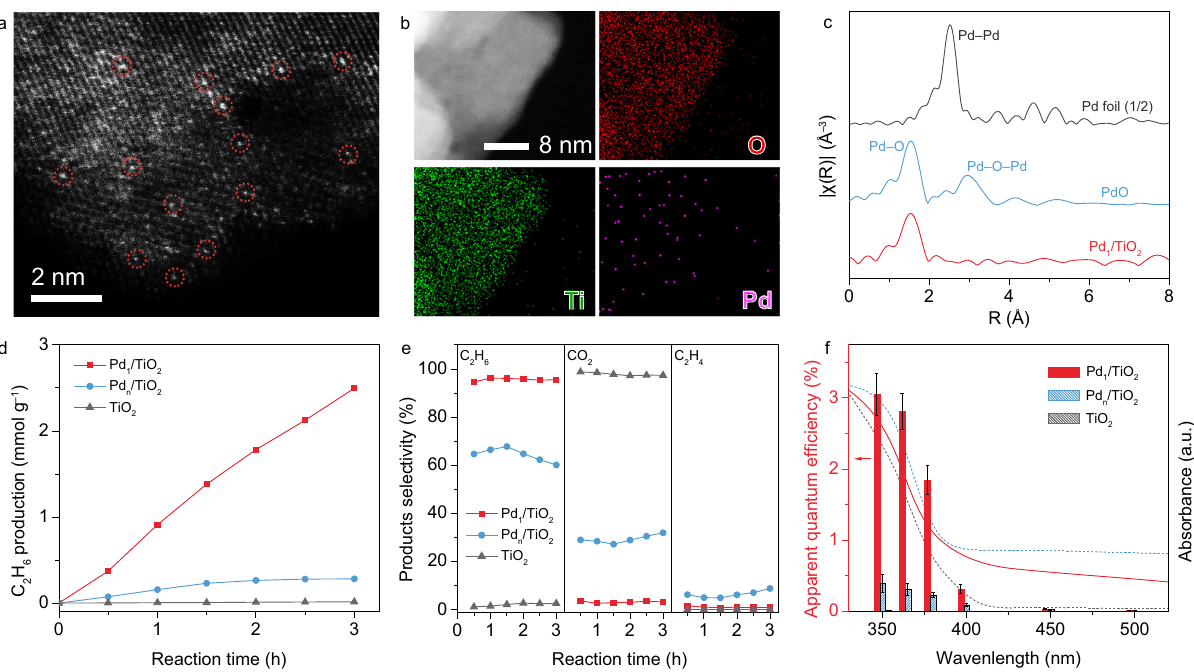
Fig. 2 Structural characterization and photocatalytic NOCM performance of Pd 1 /TiO 2 catalyst. a – c STEM image ( a ), elemental mappings ( b ) and Pd K-edge EXAFS spectra in R space ( c ) of Pd 1 /TiO 2 . The isolated Pd atoms are marked with red circles in ( a ). d , e The C 2 H 6 production rates ( d ) and the corresponding selectivity of C 2 H 6 , C 2 H 4 , and CO 2 ( e ) in 0.1 MPa CH 4 . f The AQEs for CH 4 − to − C 2 H 6 conversion with their UV-vis diffuse re fl ectance spectra as references. The error bars represent the standard deviation of the